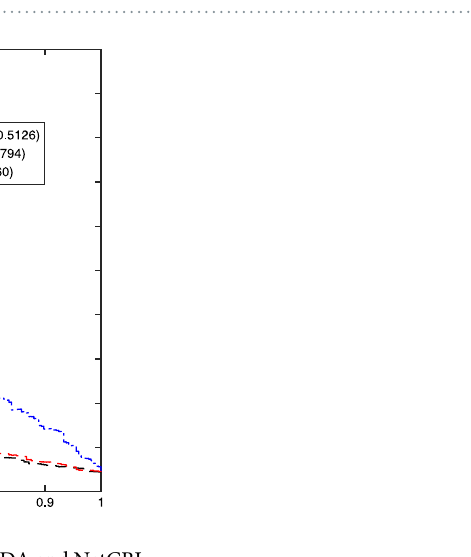
Figure 3. PR curve and AUPR values of ILRMR, RLSMDA and